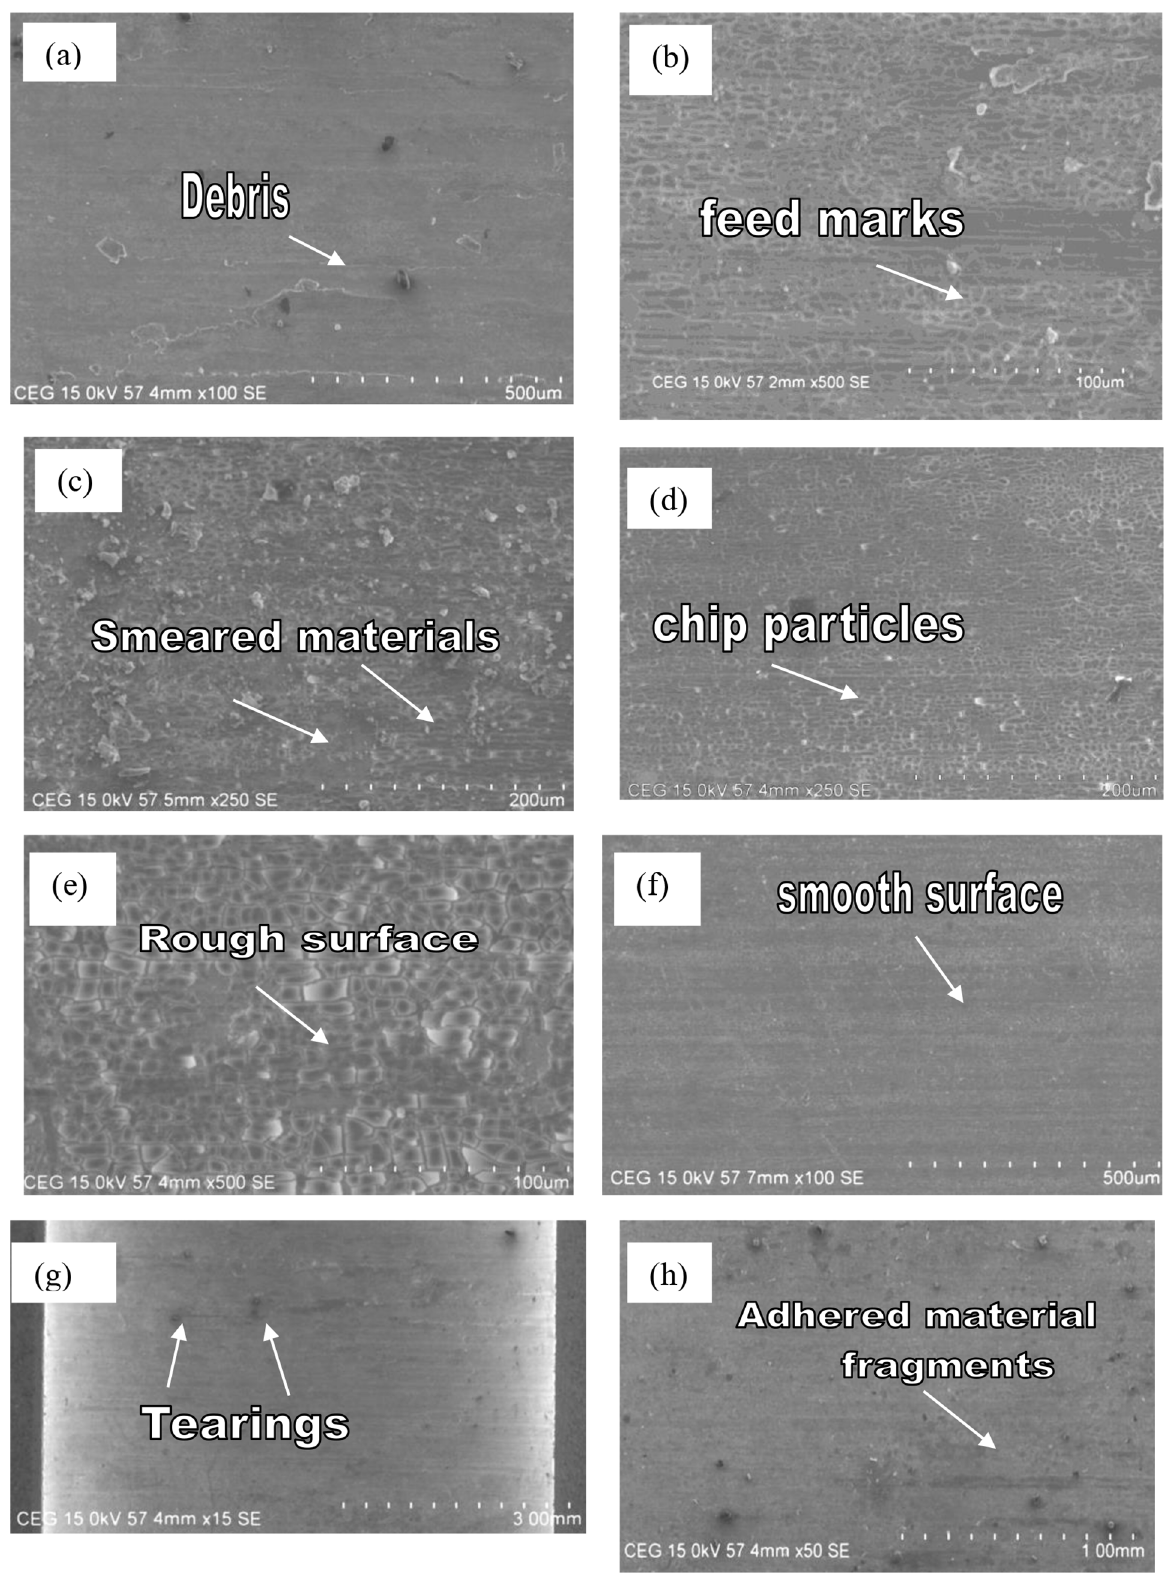
Fig. 10. (a-h) SEM Images of drilled surface at (a) N=1000 rpm, f =0.05 mm/rev, P =250* 10 3 (Pa), NP =0.5 (g), (b). N=1000 rpm, f =0.10 mm/rev, P = 500* 10 3 (Pa), NP =1% (g), (c) N=1000 rpm,f =0.125 mm/rev, P = 750* 10 3 (Pa), NP =1.5 (g), (d) N=1250 rpm, f =0.05 mm/rev, P =500* 10 3 (Pa), NP =1.5 (g) (e) N=1250 rpm, f= 0.10mm/rev, P = 7500* 10 3 Pa, NP =0.5% (g) (f) N= 1500 rpm, f =0.05 mm/rev, P = 750* 10 3 (Pa), NP=1% (g) (h) N= 1500 rpm, f =0.10 mm/rev, P = 250* 10 3 (Pa), NP =1.5%